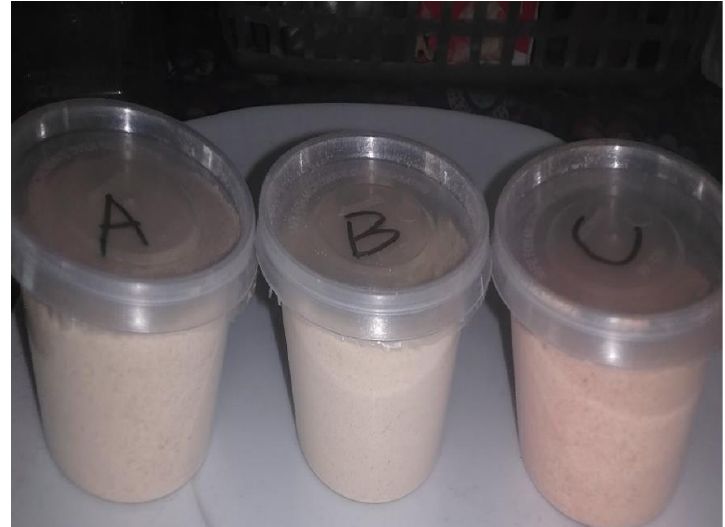
Figure 6. Flour blends of samples packaged in plastic containers. The sensory scores for color ranged from 7.15–7.70. All the samples had a rating of seven points for color. Sample CTRL (commercial product) scored 7.15, sample AS scored 7.70, and sample ASO scored 7.55. However, no significant ( p > 0.05) differences existed among all the samples. Sample CTRL (commercial product) and sample AS had a milky color, whereas sample ASO had slightly orange color as a result of the addition of OFSP. Fermentation produced a slightly darker color, which may be attributed to the influence of mycelia color and drying. However, all the colors were generally accepted by the